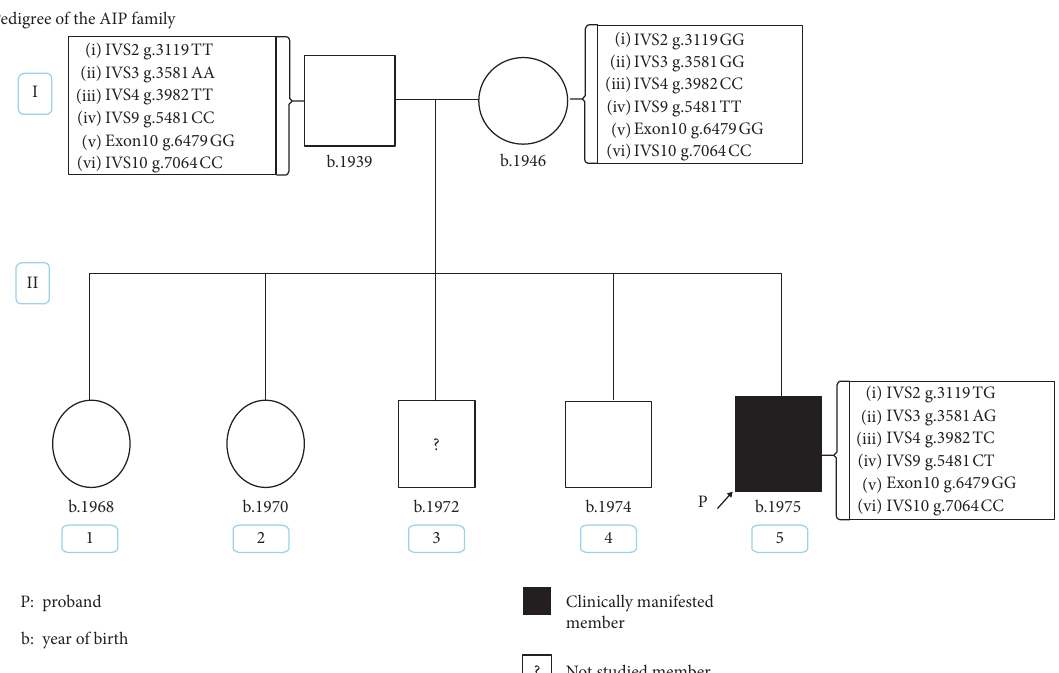
Figure 3: Allele segregation analysis using intragenic SNPs in HMBS . SNP underlined indicates a novel SNP in Argentinean population. Position of nucleotide change is numbered relative to the translation initiation codon in Exon 1 in genomic DNA sequence (GenBank accession no. M95623, A in the ATG initiation codon for the housekeeping isoform is